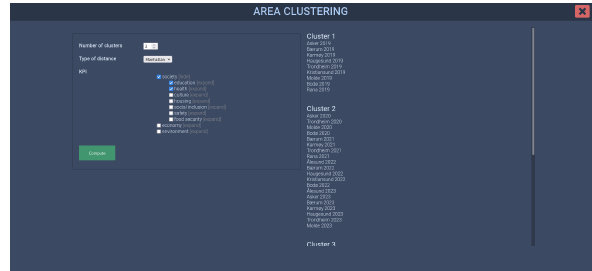
Figure 10. Screenshot with clustering results.